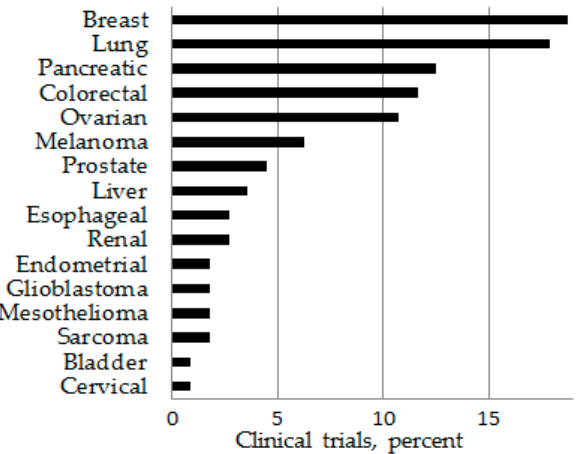
Figure 2. Immunotherapy trials in ClinicalTrial.gov.